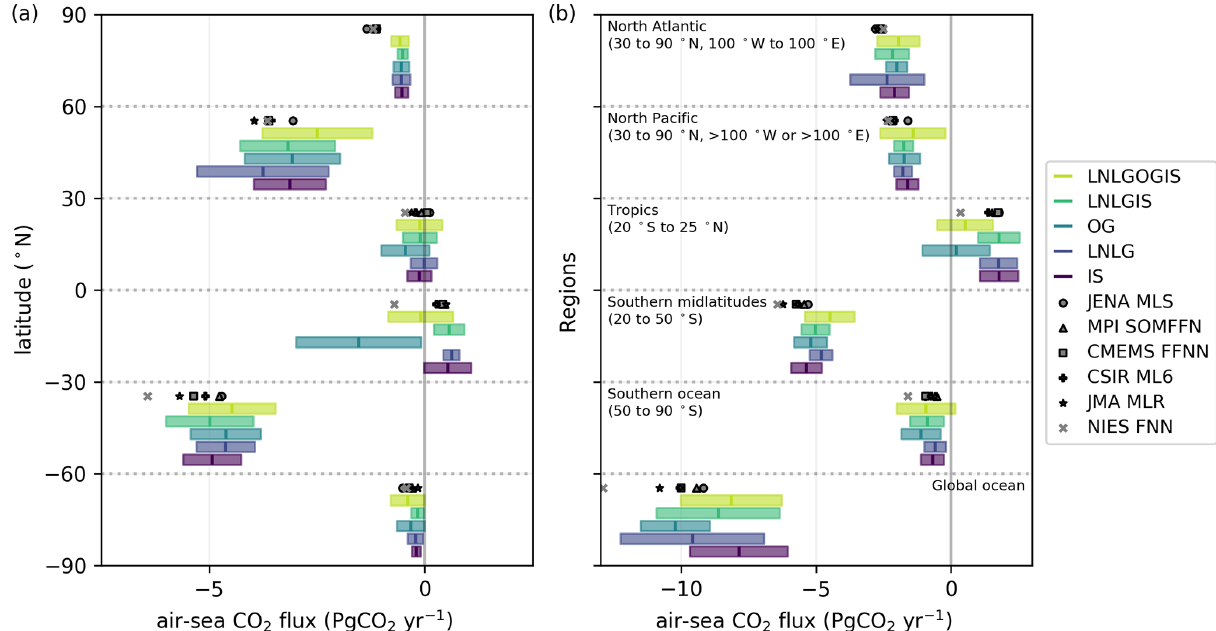
Figure 7. (a) Zonal mean air–sea CO 2 flux (positive values represent flux towards atmosphere) for 30 ◦ increments of latitude based on 1 ◦ × 1 ◦ estimates averaged over 2015–2019. (b) Air–sea CO 2 flux for six large ocean regions. Colored bars show the MIP experiment results (median ± 1 standard deviation), and the symbols show the p CO 2 -based air–sea fluxes from the six SeaFlux